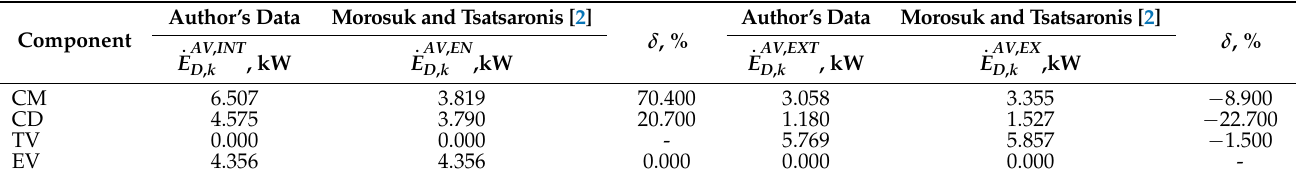
Table 9. Comparison of the results of the avoidable of exergy destruction rates obtained by authors and presented in [2].